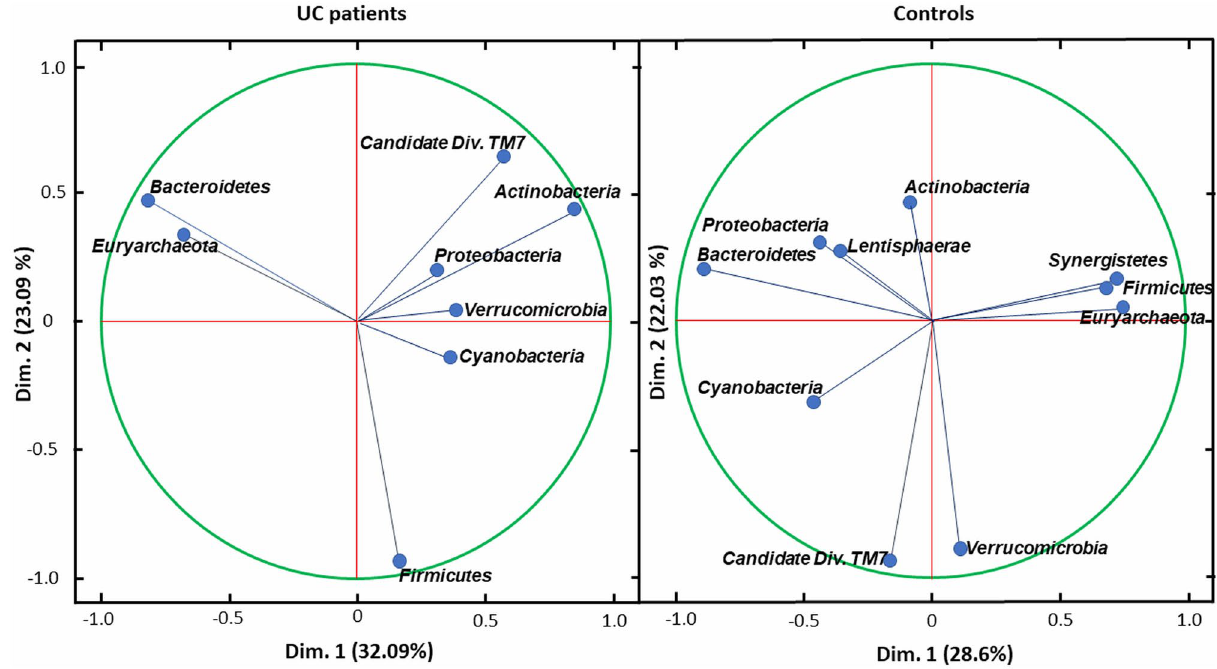
Figure 5. Projection of the variables at phylum level on the two dimensions biplot for UC patients (left) and controls